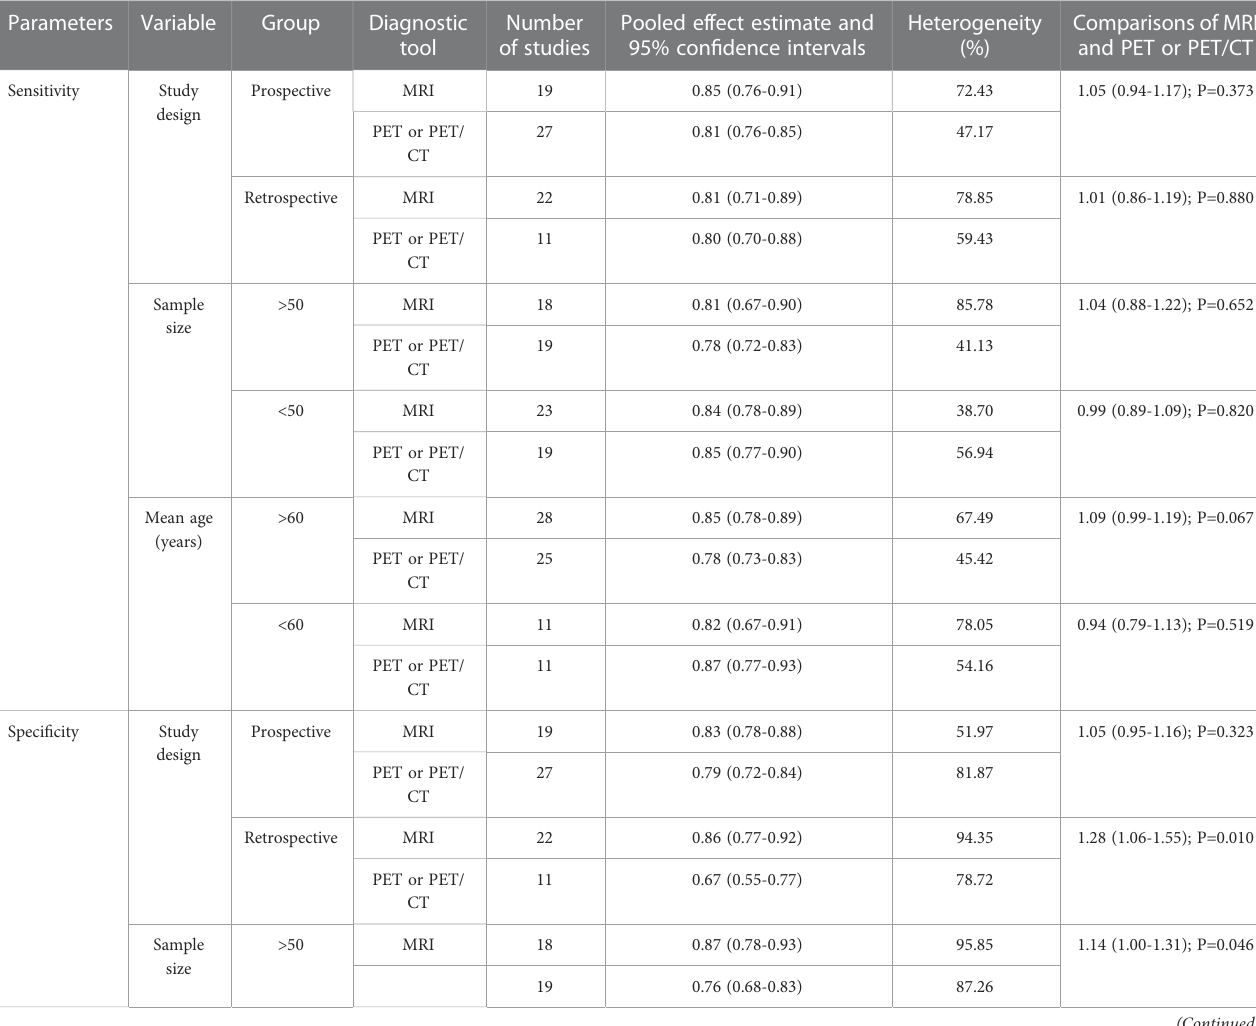
Heterogeneity Comparisons of MRI (%) and PET or PET/CT